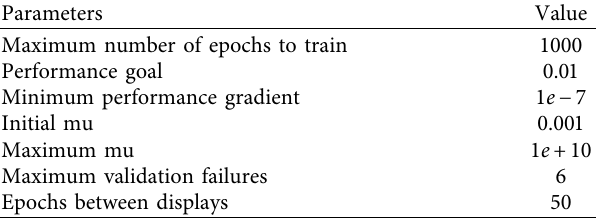
Figure 1: MLF architecture. Table 3: Training